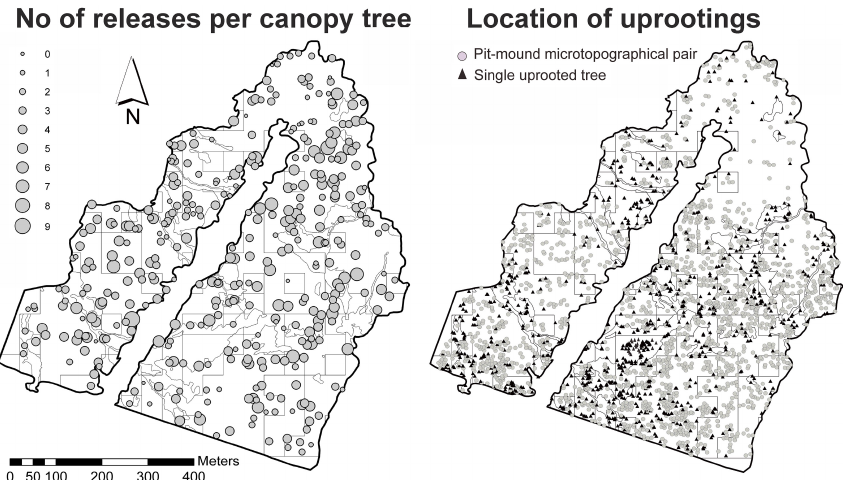
Figure 6. “Footprints” of disturbance events in the Žofín core zone. The left panel represents the number of releases per canopy tree; only trees which have already reached the tree canopy are shown ( n = 682). Locations of trees were used for evaluating the spatial pattern of releases (for details see Sect. 3.4.1). The right panel shows the occurrence of treethrow pit–mounds with or already without the uprooted tree. Locations of pit–mounds served to calculate spatial relations between soil disturbances (see Sect.